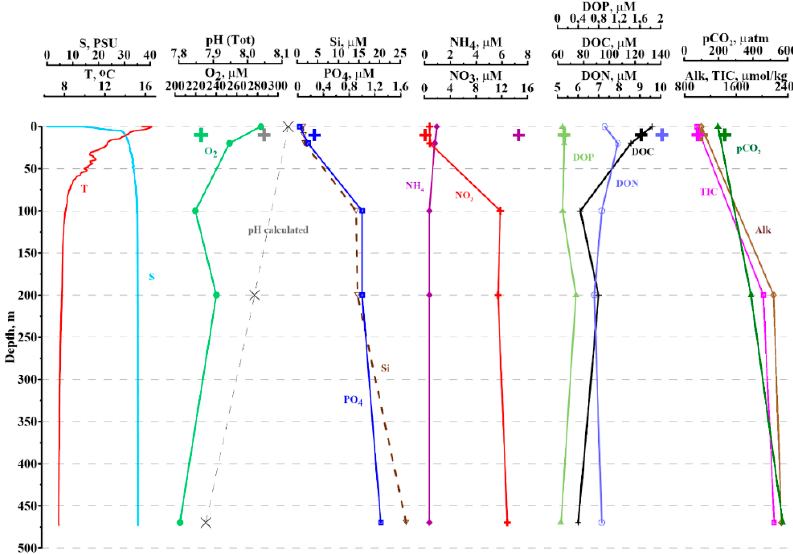
Figure 5. Observed vertical distributions of temperature (T), salinity (S), dissolved oxygen (O 2 ), phosphate (PO 4 ), silicate (Si), nitrate and nitrite (NO 3 ), ammonia (NH 4 ), dissolved organic carbon (DOC), dissolved organic nitrogen (DON), dissolved organic phosphorus (DOP), total alkalinity (Alk), dissolved inorganic carbon (DIC), partial pressure of CO 2 (pCO 2 ), and pH calculated as a function of Alk and TIC at Station 6 located about 1000 m from a fish farm (lines) and values in the sample collected at 10 m depth and 20 m horizontal distance from the farm at Station 7 (bold crosses).